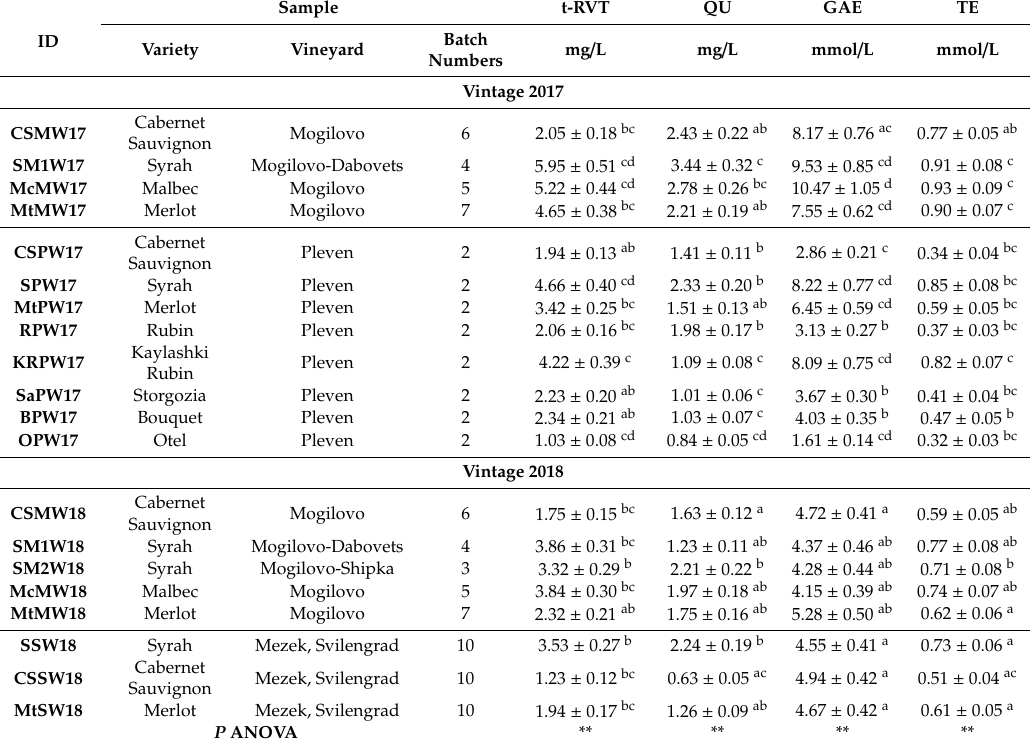
Table 2. Red wines, vintage 2017 and 2018.